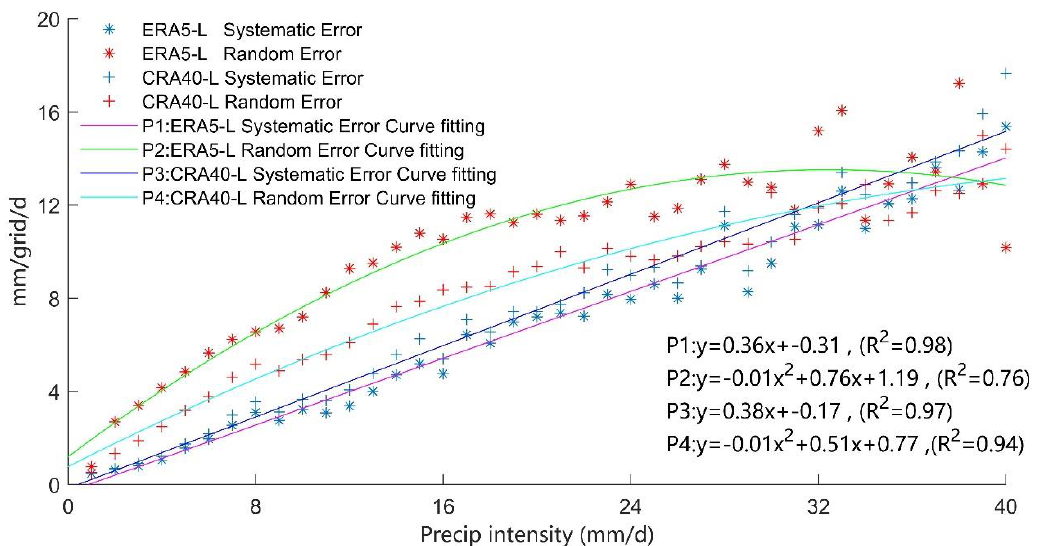
Figure 6. Correlation of the precipitation intensity with systematic and random error components.